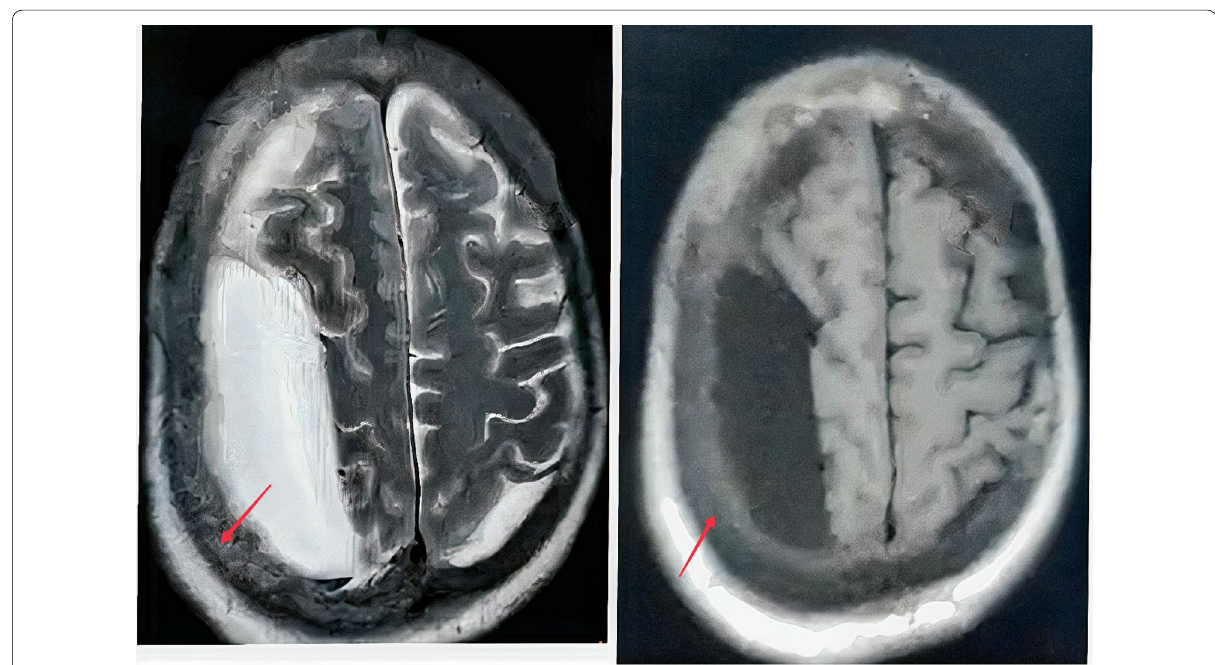
Fig. 2 MRI brain showing T2 and T1 images-right temporal, parietal hypodense lesion and left parietal lesion with dural thickening